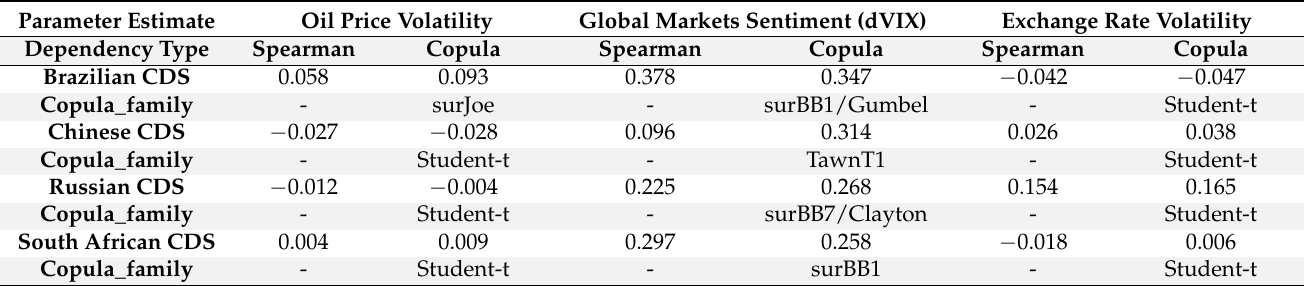
Table 3. Dependency structure of sovereign CDS and global risk factors in